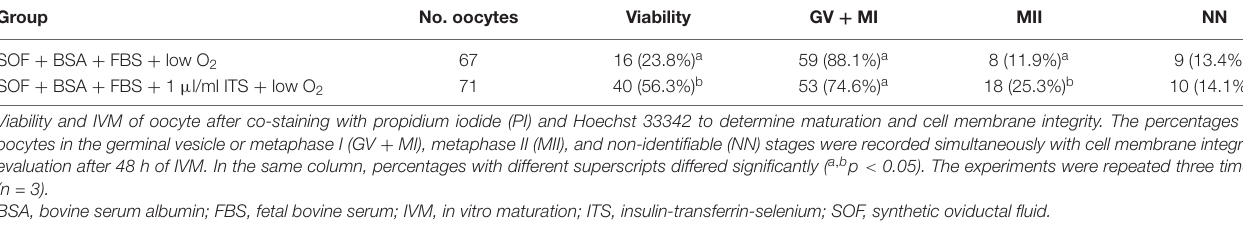
TABLE 5 | Viability and IVM of canine oocytes in SOF + BSA + FBS medium for 48 h under low O 2 tension atmospheres in the presence or absence of ITS. Group No. oocytes Viability GV + MI